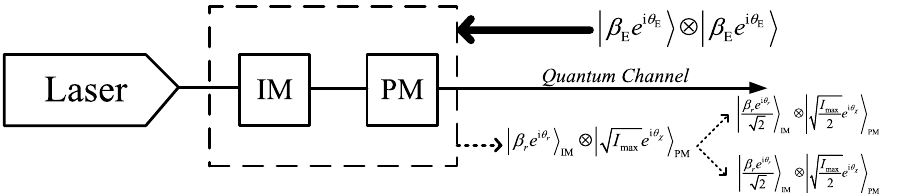
Figure 5. Example of a THA against correlated IM and PM of Alice (Bob). The simulation is similar to that in s,v,w,0 Fig. 2 but now r . Moreover, we assume that Eve splits the joint back-reflected light into two parts by ∈ { } means of a 50:50 beamsplitter, one part is to learn information about the intensity settings and the other part is used to learn information about the basis